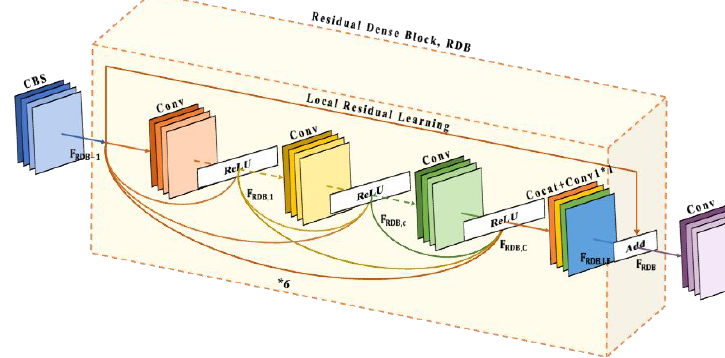
Figure 6. The network structure of Residual Dense Block (RDB).